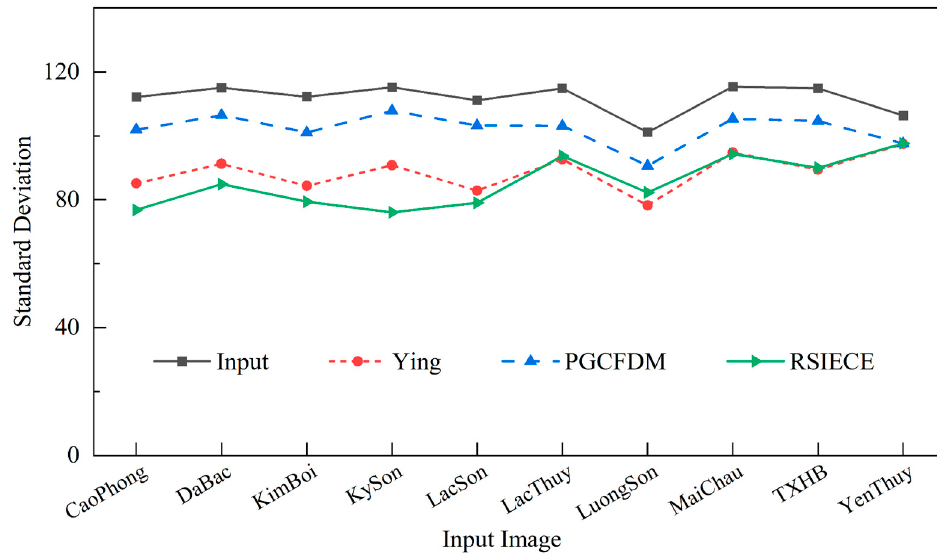
Figure 5. Comparison of the quality of the enhanced images by the RSIECE algorithm with that of the Ying and PGCFDM methods in terms of the standard deviation criteria.